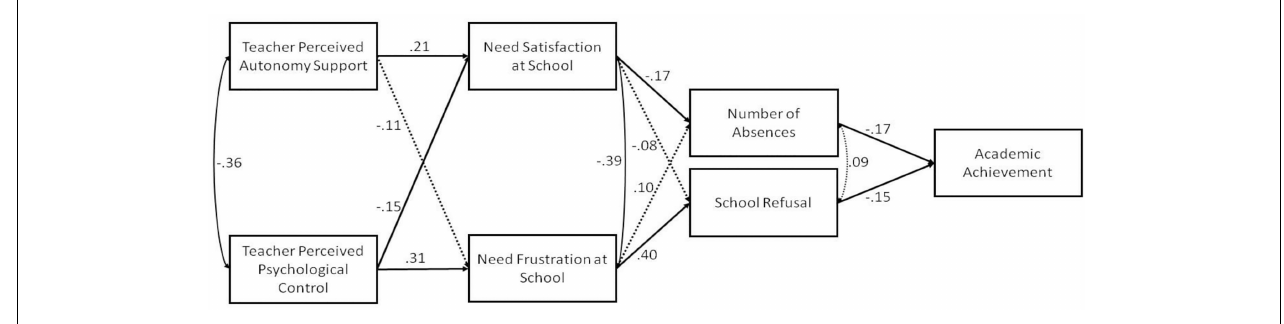
FIGURE 1 | Path diagram depicting the relationships between study